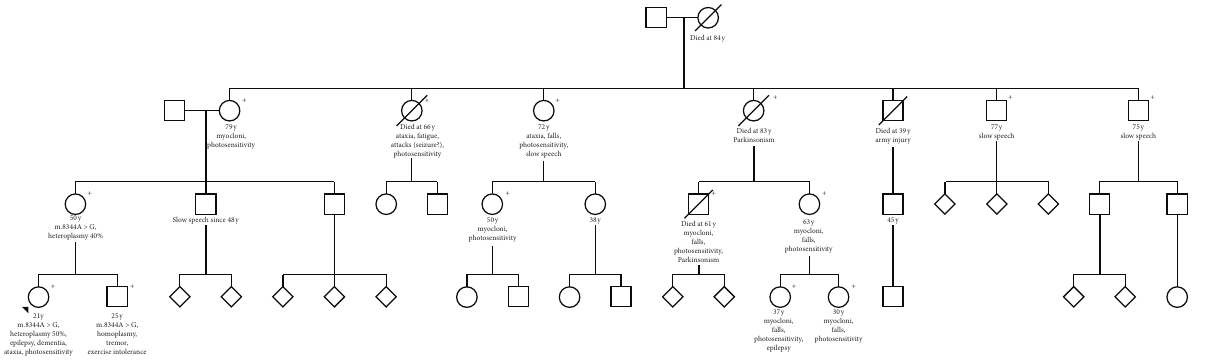
Figure 3: Pedigree of the index patient’s family (the “+” indicates that the individual was clinically